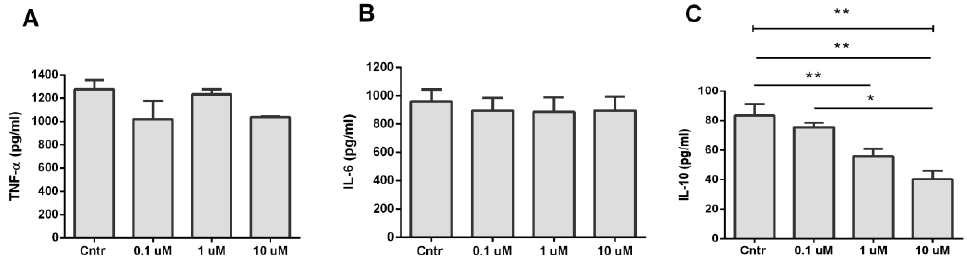
Figure 7. Cytokine levels in macrophage culture medium. Macrophages THP-1M φ were treated with various doses of PNU 282,987 for 30 min, after which they were stimulated with lipopolysaccharide (LPS). The levels ( A ) of tumor necrosis factor- α (TNF- α ), ( B ) interleukin (IL)-6 and ( C ) IL-10 were determined after 24 h by ELISA. Bars are expressed as mean ± SEM. Data were obtained in three independent experiments. One-way ANOVA tests with Turkey post hoc test: * p < 0.05, ** p < 0.01.